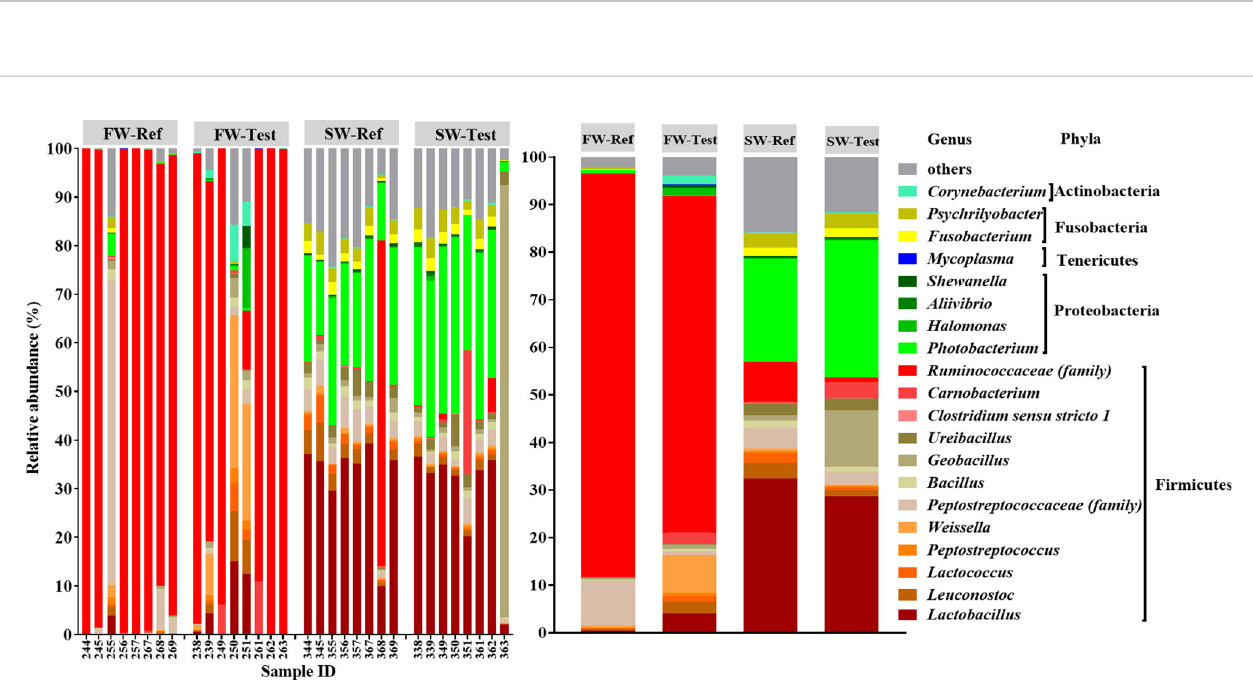
FIGURE 7 | Alpha diversity (A, B) and beta-diversity (C, D) of the microbiota in distal intestinal digesta among treatments. Data are presented from min to max with all points. Different letters among values denote signi fi cant differences ( p < .05, n = 8).